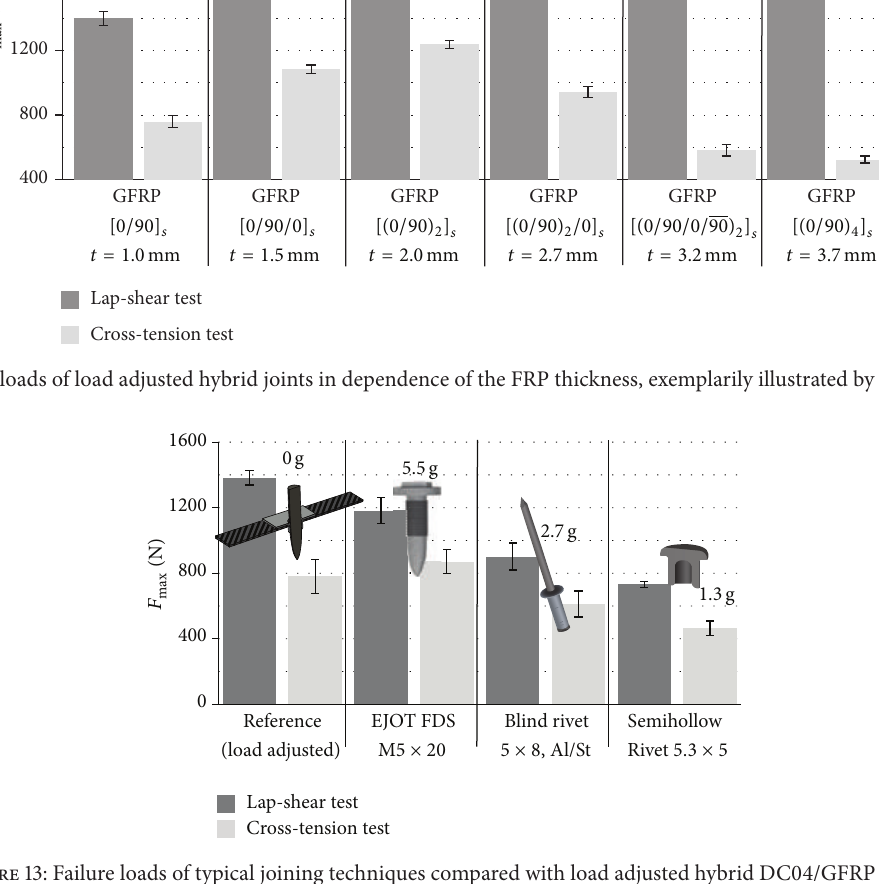
Figure 13: Failure loads of typical joining techniques compared with load adjusted hybrid DC04/GFRP joints.